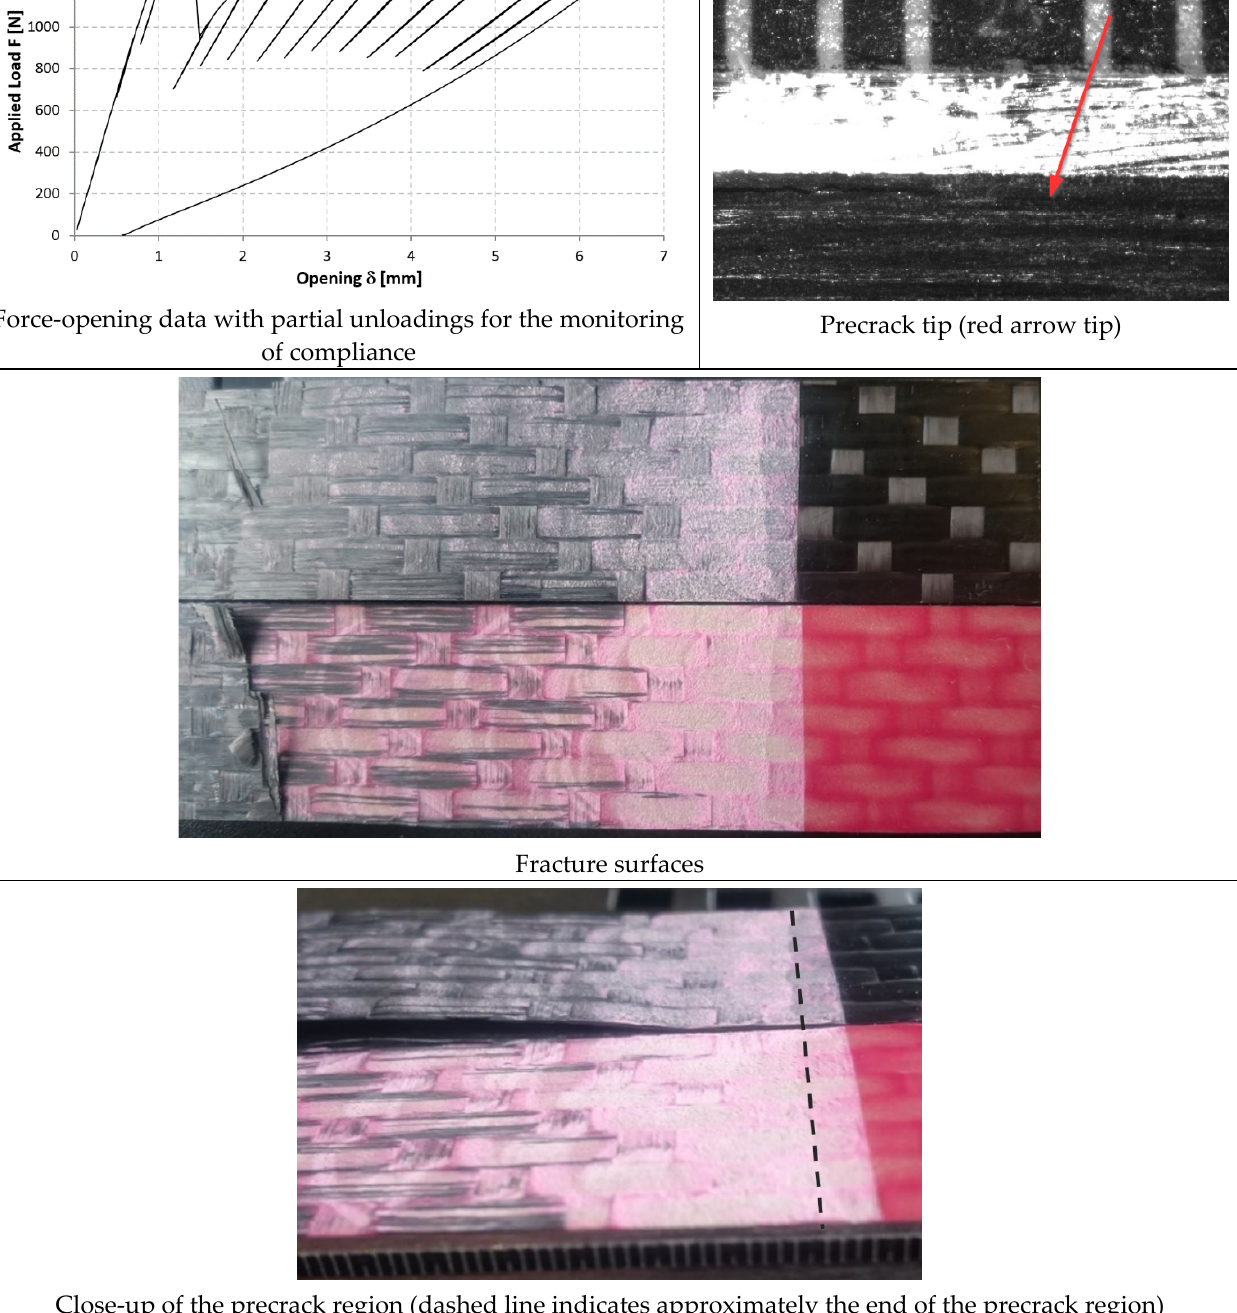
Figure 15. Results of the test on specimen DCB_AF163_02.